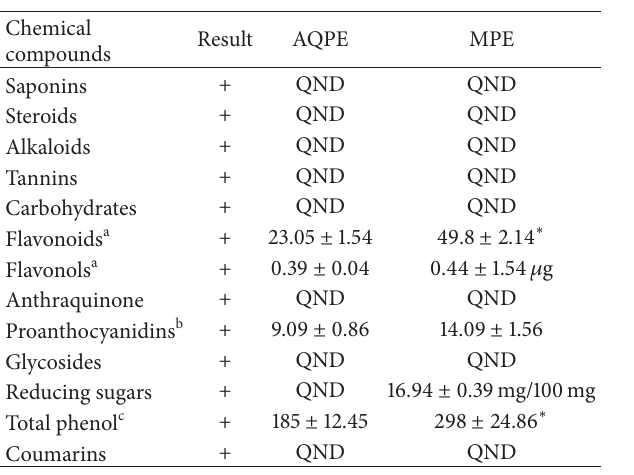
Table 1: Preliminary phytochemical screening of the Punica grana- tum peel extract.